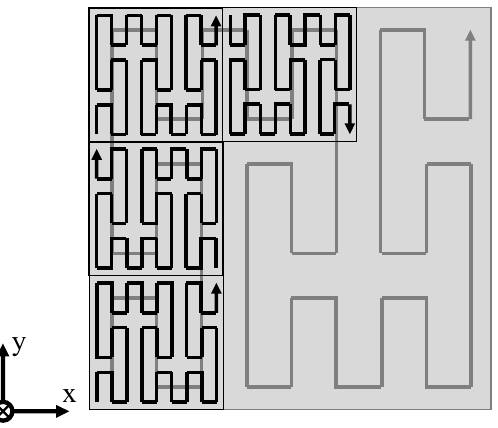
Figure 5. Schematic illustration of the fractal exposure sequence of distinct segments.